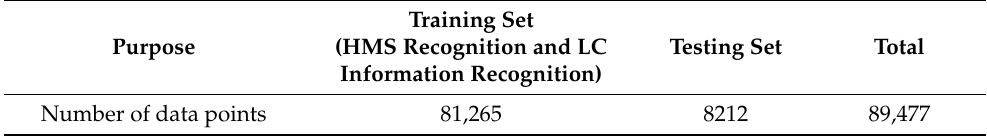
Table 4. Composition of dataset used in the